Question: How would you classify this visualization?
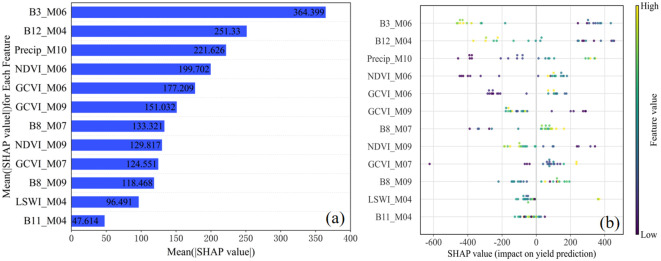
Answer: histogram